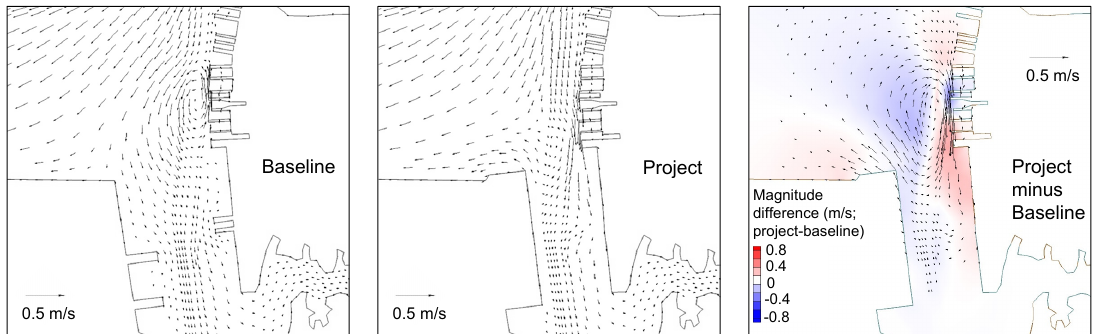
Figure 18. Flood current (depth-averaged) at the peak of Hurricane Sandy. Note that the color scheme in the right panel shows the difference between vector magnitudes ( | (cid:126) v 1 | − | (cid:126) v 2 | ), but not the magnitude of vector difference ( | (cid:126) v 1 − (cid:126) v 2 |